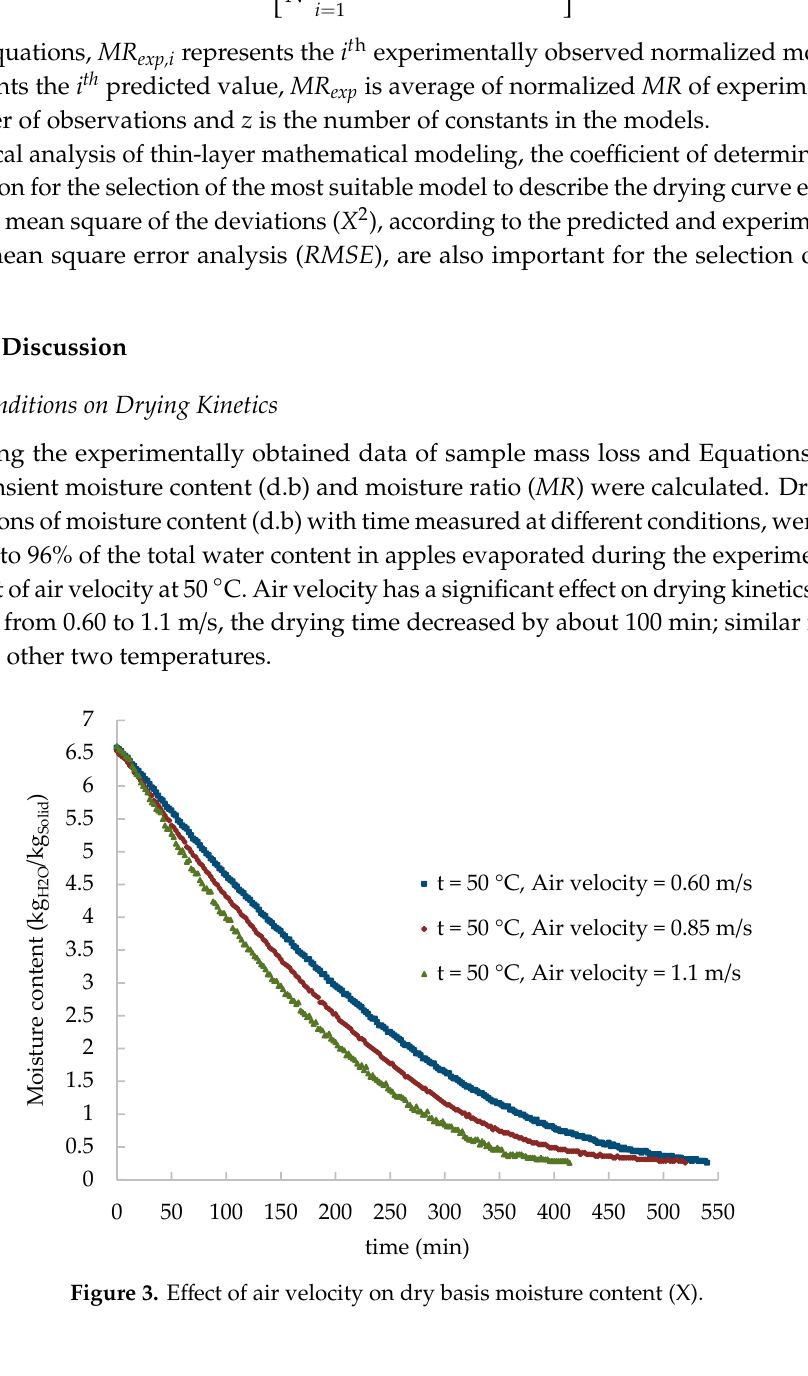
Figure 4. Effect of temperature on dry basis moisture content (X). Slice thickness has a significant effect on drying kinetics. While for 4 mm slices, the required degree of drying was achieved after 300 min; for 12 mm slices, one working day (maximum 10 h) was not enough and measurement was stopped after 8.5 h and continued on the second day. This is the reason of the break on the curve for 12 mm slices in Figure 6. At high moisture content (at the beginning of the experiment) when free water from the apples is evaporated, the effect of slice thickness is not significant; however, by decreasing the moisture content, the drying rate is limited by water diffusion to the surface and the effect of slice thickness becomes crucial.